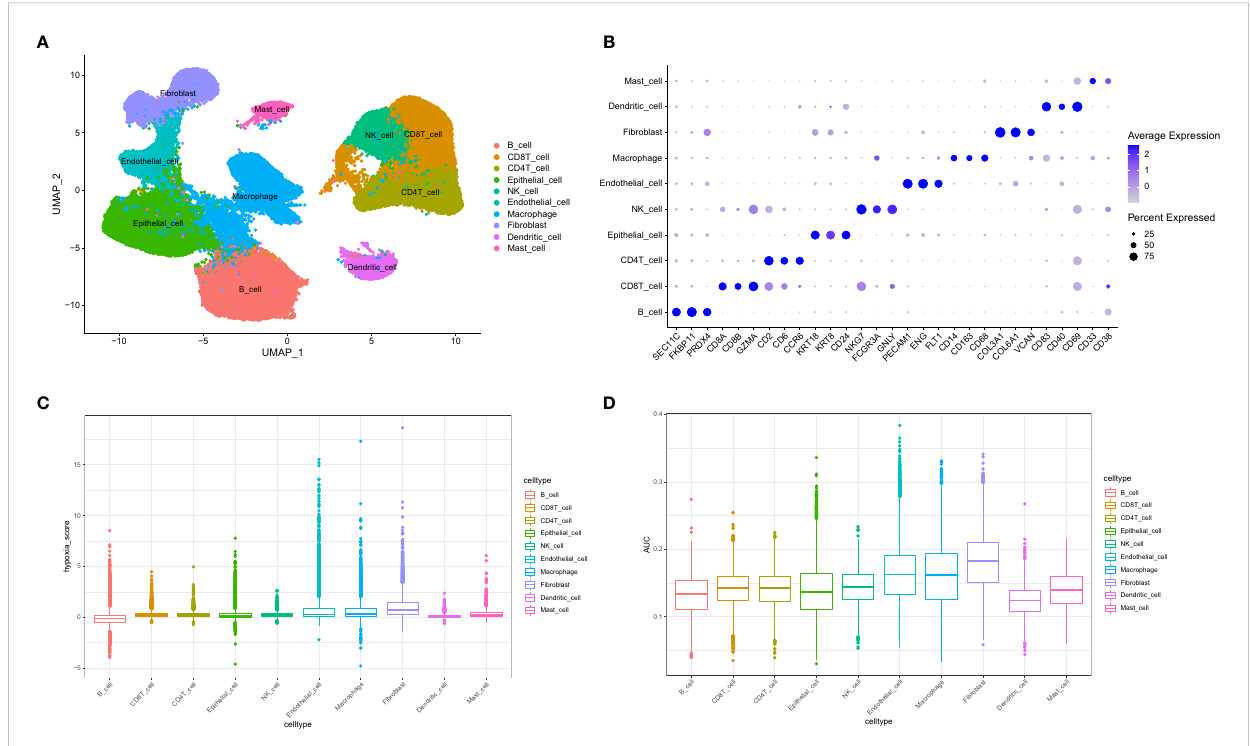
FIGURE 2 Overview of single-cell data. (A) UMAP of ten different cell types of samples. (B) Cell markers used to identify cell types. (C) Hypoxia score calculated by the AddModuleScore function. (D) Hypoxia-related AUC calculated by the AUCell